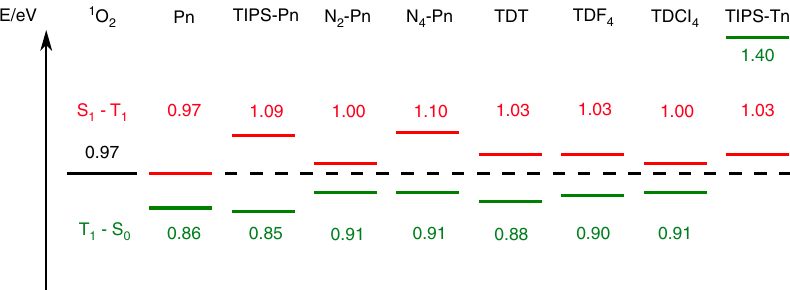
Fig. 6 Relative energy differences for selected SF molecules. N 2 -Pn, N 4 -Pn, TDT, TDF 4 , TDCl 4 and TIPS-Pn stand for diaza-TIPS-pentacene 19,20 , tetraaza- TIPS-pentacene 19,20 , phenazinothiadiazole 14 , tetra fl uorphenazinothiadiazole 14 , tetrachlorphenazinothiadiazole 14 and TIPS-tetracene 14 , respectively. The S 1 – T 1 (red) and T 1 – S 0 (green) energy gaps are shown and compared with the 1 O 2 – 3 O 2 lowest energy gap of molecular oxygen (black). The feasibility of